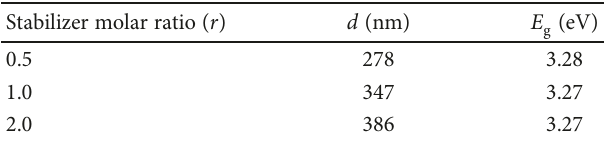
Figure 8: Optical transmittance spectra of ZnO thin fi lms deposited at di ff erent stabilizer molar ratios. Table 4: Values of the optical gap and thickness as a function of the stabilizer molar ratio for ZnO thin fi lms obtained when propanol is used as